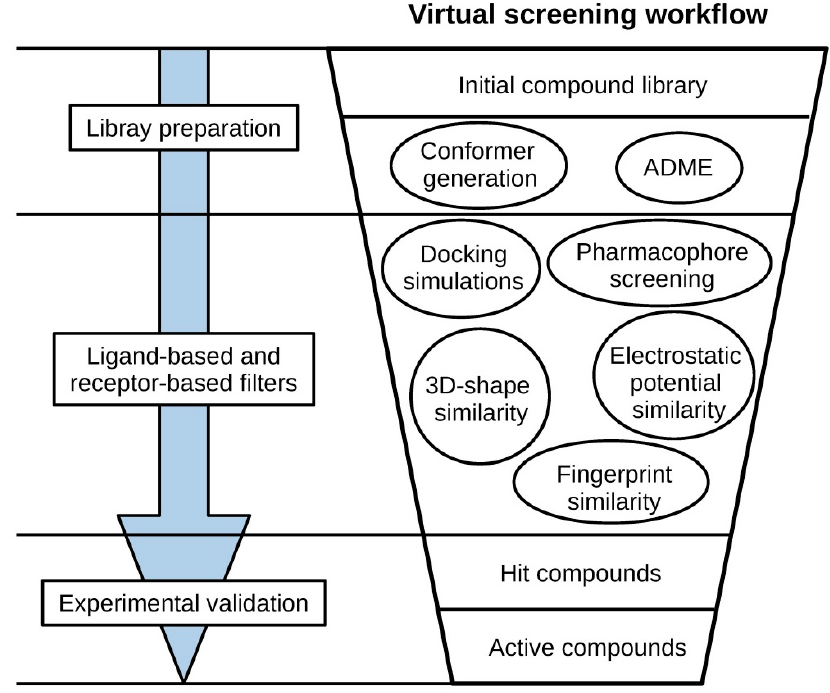
Figure 1. General scheme of a virtual screening workflow.